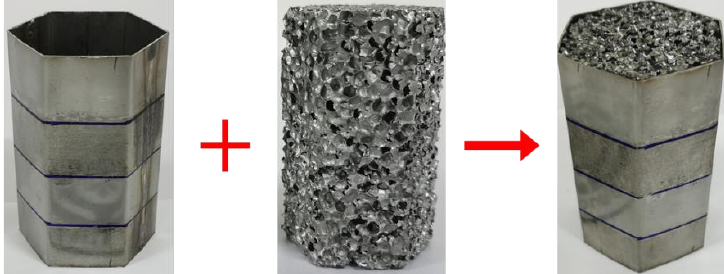
Figure 19. Configuration of FLNT-4.